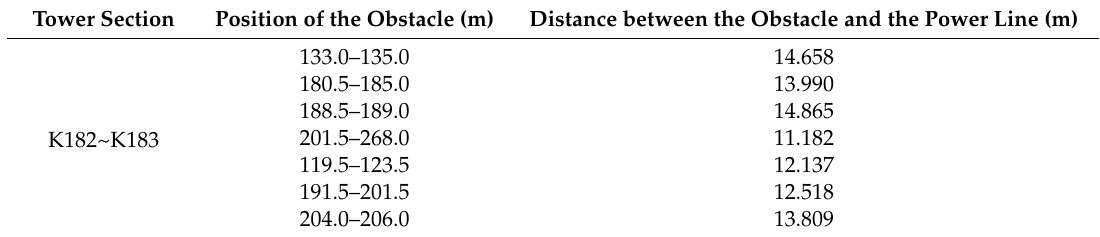
Table 1. Distribution of Some Obstacles within the Power Line Corridor (safety distance threshold is 15 m). Tower